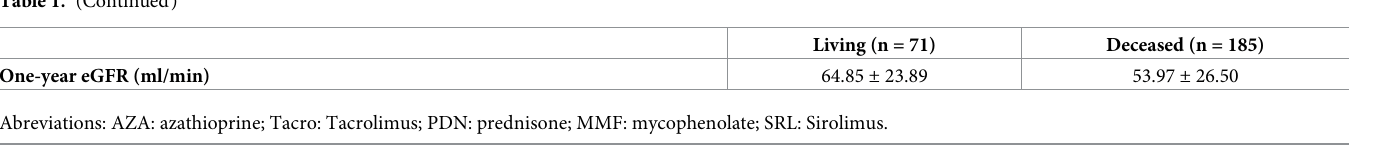
PLOS ONE | https://doi.org/10.1371/journal.pone.0224364 November4,